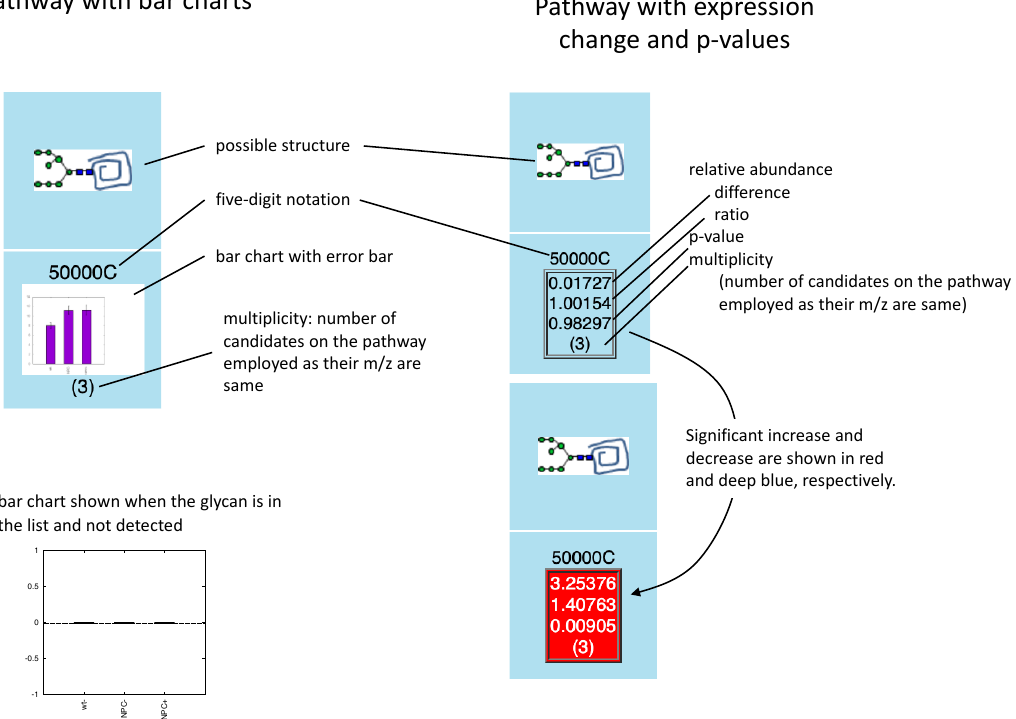
Figure 9. Two di ff erent methods for visualizing alterations; bar chart ( left ) and mean relative abundance and p -value ( right ). In the bar chart, the three bars show wt( − ), NPC( − ), and NPC( + ) expression levels,